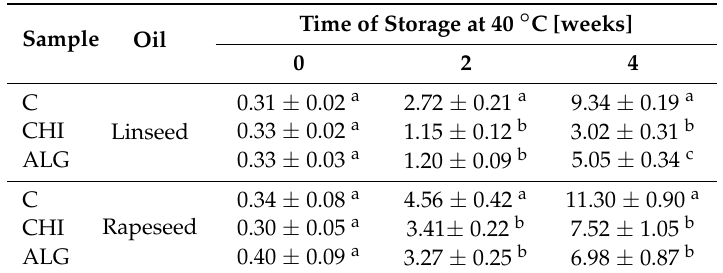
Table 3. Comparison of the change of the content of secondary oxidation products (SOPs) in non-encapsulated and encapsulated rapeseed and linseed oil during four weeks of storage at 40 ◦ C (C—non-encapsulated oil, CHI—oil encapsulated with chitosan, ALG—oil encapsulated with sodium alginate).